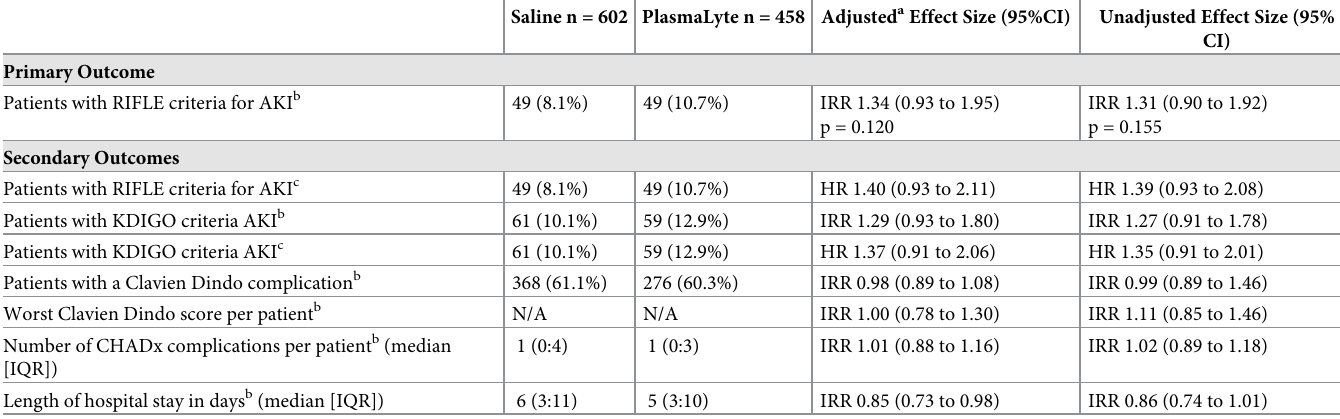
Table 2. The Incidence Rate Ratios (IRR) and Hazard ratios of outcomes for patients receiving Plasma-Lyte vs Saline after surgery.